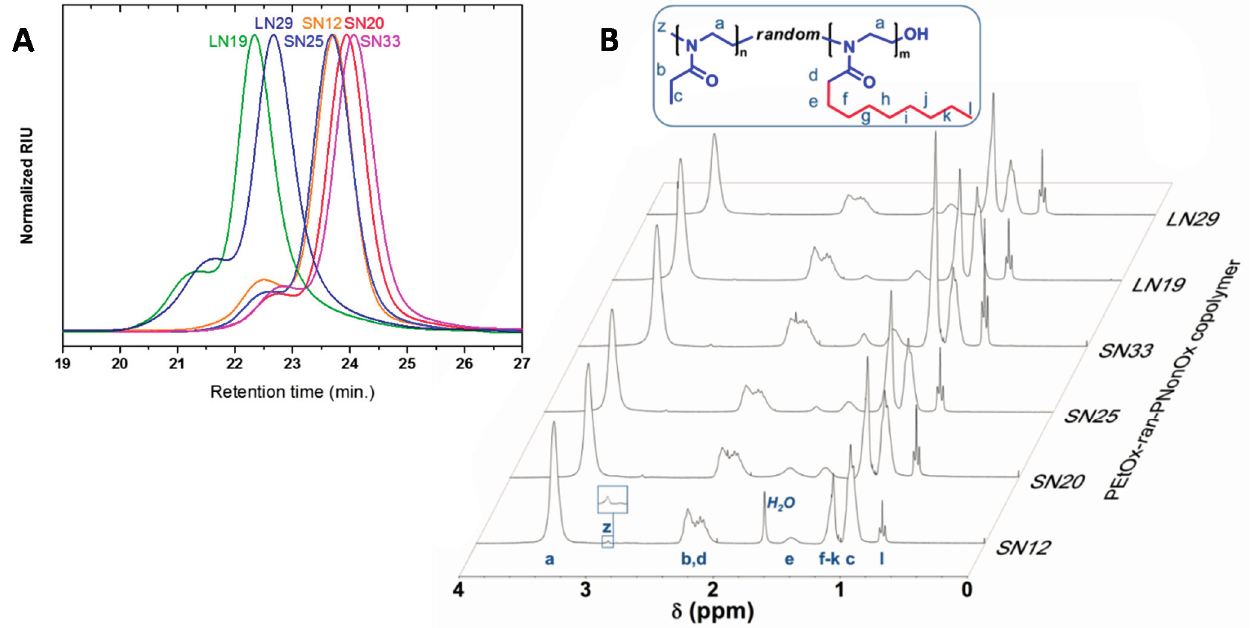
Figure 3. ( A ) Size exclusion chromatography (SEC) data of the synthesized PEtOx n - ran -PNonOx m random copolymers. Albeit a high molecular weight distribution is observed as shoulder in all cases, ascribed to chain coupling, well-defined polymers with dispersities around 1.1 were obtained. SEC eluent: N , N -dimethylacetamide containing 50 mM LiCl; ( B ) 1 H-NMR spectra of the investigated PEtOx- ran -PNonOx random copolymers in CDCl 3 . Legend: S = Short polymer, DP ≈ 100, L = Long polymer DP ≈ 200. N = % Nonyl side chains in